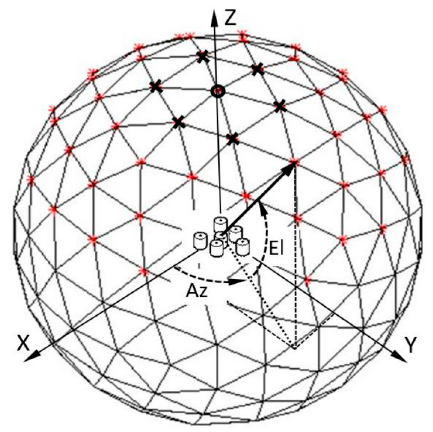
Figure 1. An illustration of a 2D-angle-grid formed by an icosphere-based mesh, and a 6-element RSA. The array phase-reference center (defined at the first element in the center of the array) and the icosphere center are collocated at the origin of the XYZ-coordinate system